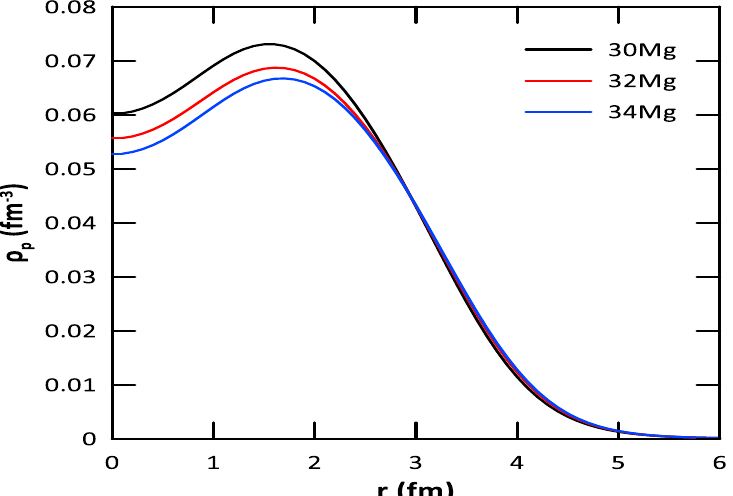
Fig. 5(b): The relation between proton density (fm -3 ) and position r(fm) for 30,32,34 Mg